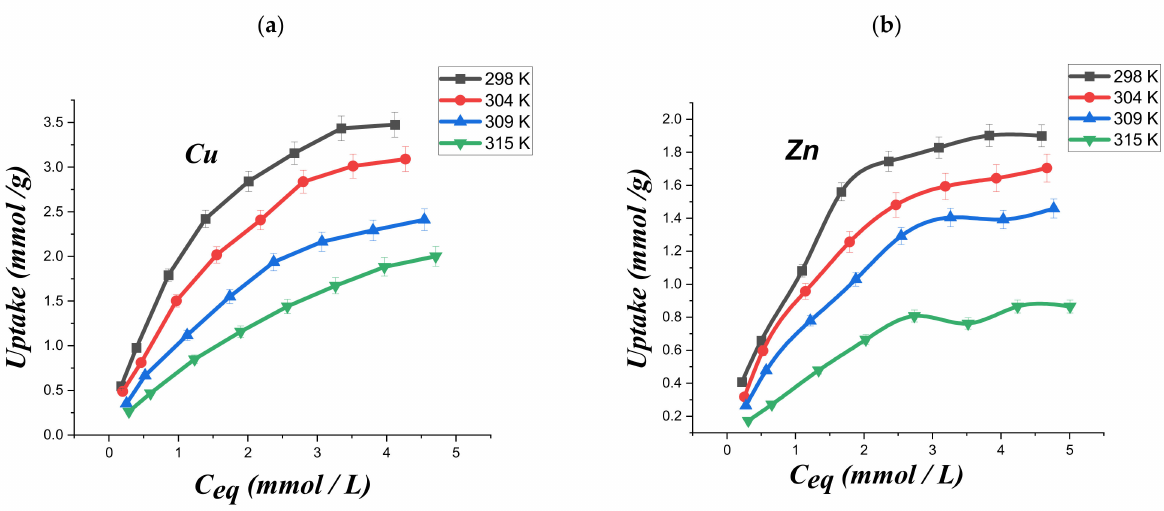
Figure 8. Adsorption isotherms for copper ( a ) and zinc ( b )